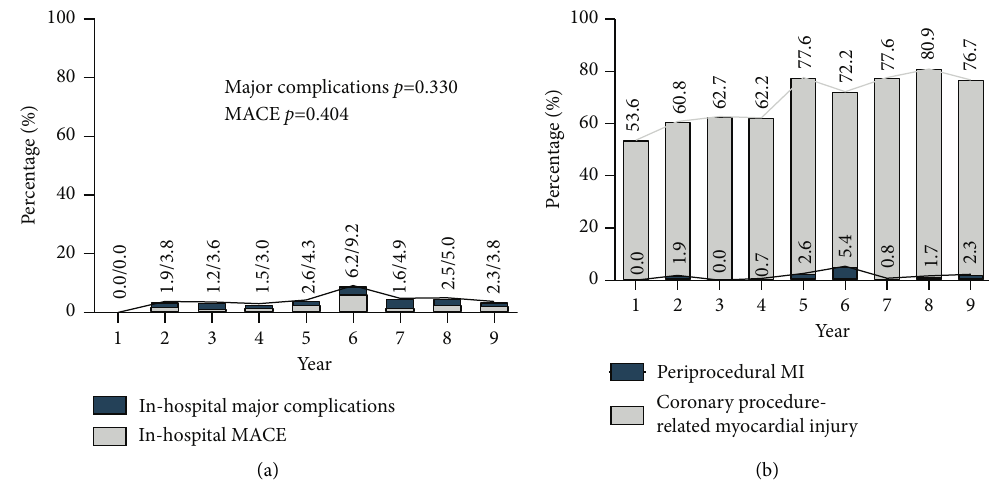
Figure 2: Temporal trends in the complications. (a) Stable rates of in-hospital major complications and MACE (cardiovascular death, stroke, and periprocedural MI) ( p value for trend 0.330 and 0.404, respectively). (b) A significant temporal increase in the rate of coronary procedure-related myocardial injury ( p value for trend < 0.001), without an increase in periprocedural MI ( p value for trend 0.310). MACE, major adverse cardiovascular events; MI, myocardial infarction; URL, upper reference